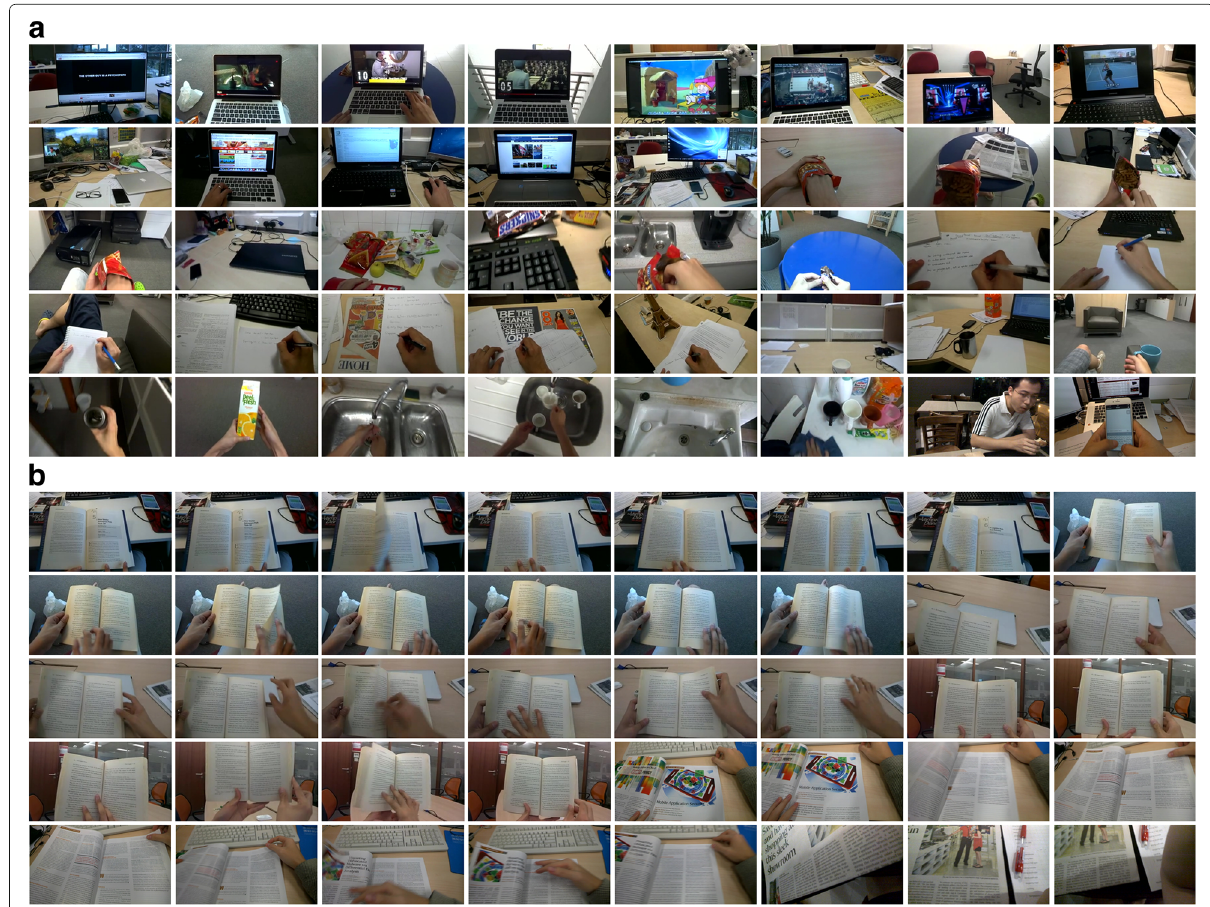
Fig. 7 Example images of two public datasets for test. a “Others” class. b “Reading”